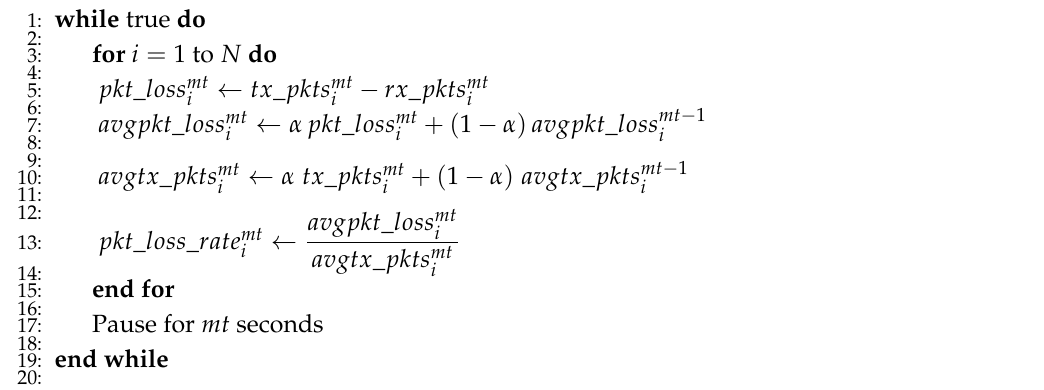
Algorithm 2 Packet-loss